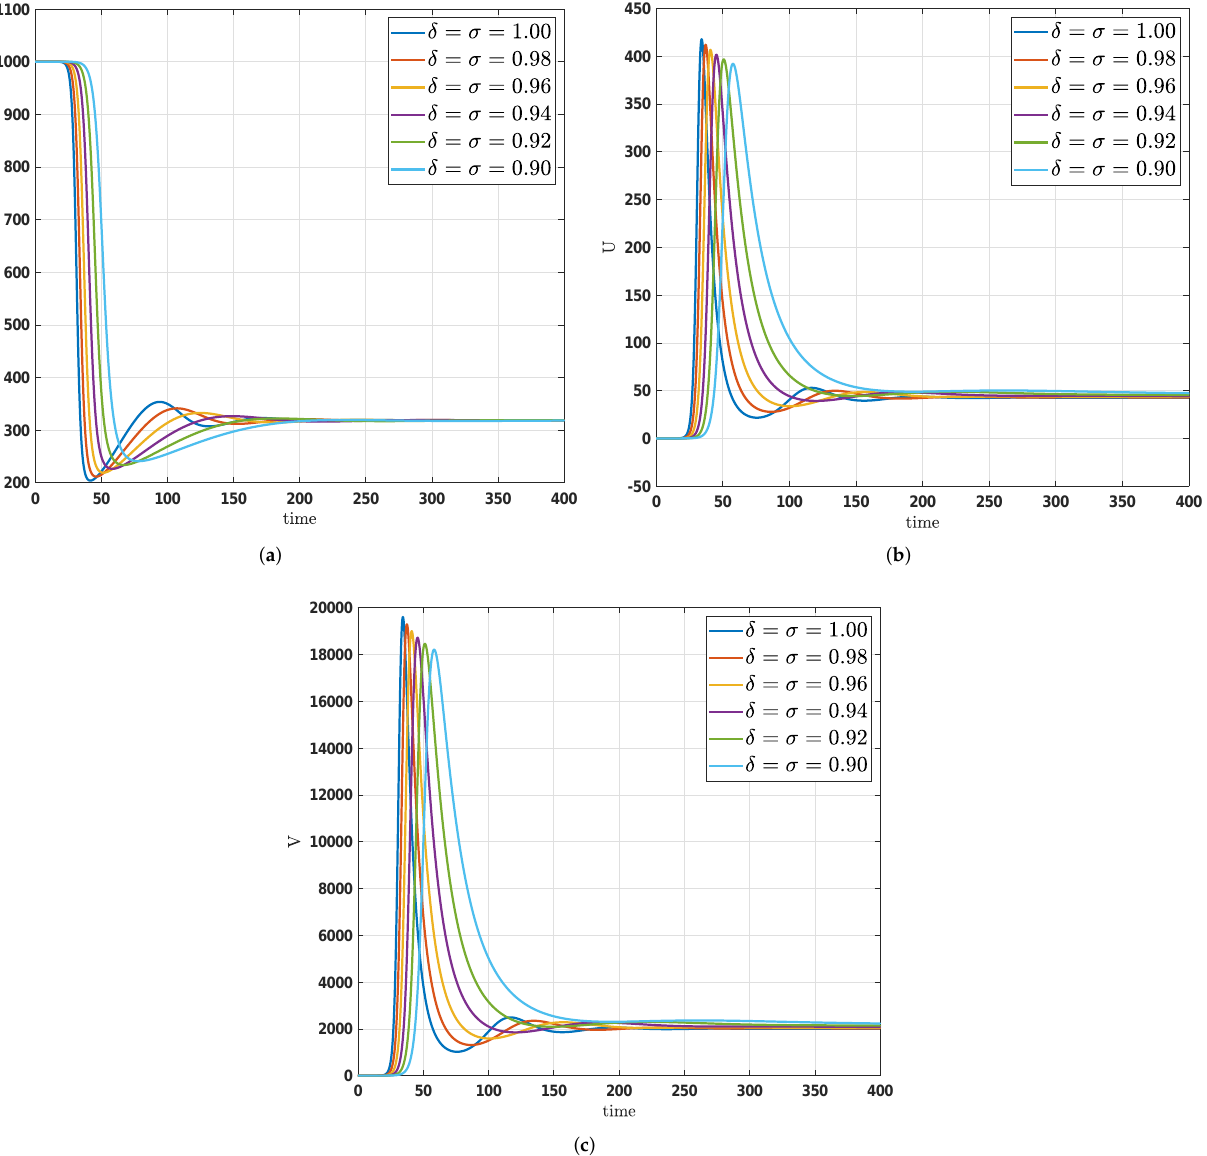
Figure 1. Numerical trajectories by varying both fractal order and fractional order δ = σ = 1.00, 0.98, 0.96, 0.94, 0.92, 0.90 via the Adams-Bashforth method. ( a ) Amount of susceptible CD4 + T-cells. ( b ) Amount of infectious CD4 + T-cells. ( c ) Free particles of the infection of the HIV-1 virus in the